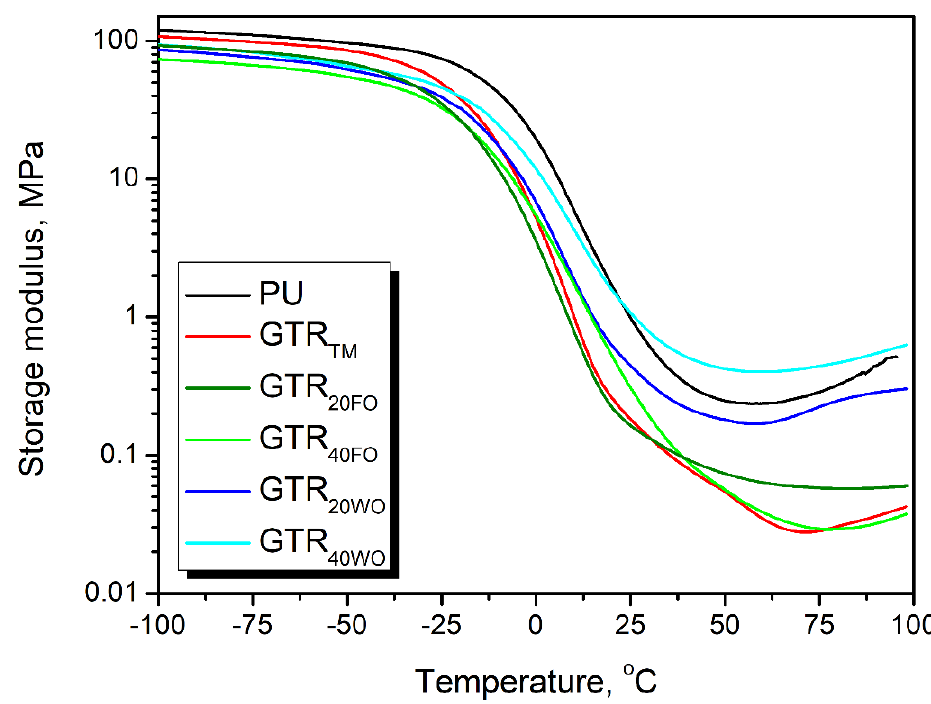
Figure 4. The temperature plot of storage modulus of prepared foams. Figure 5 and Table 6 present the results of thermogravimetric analysis of applied GTR fillers. The onset of the TM sample, determined as the temperature corresponding to